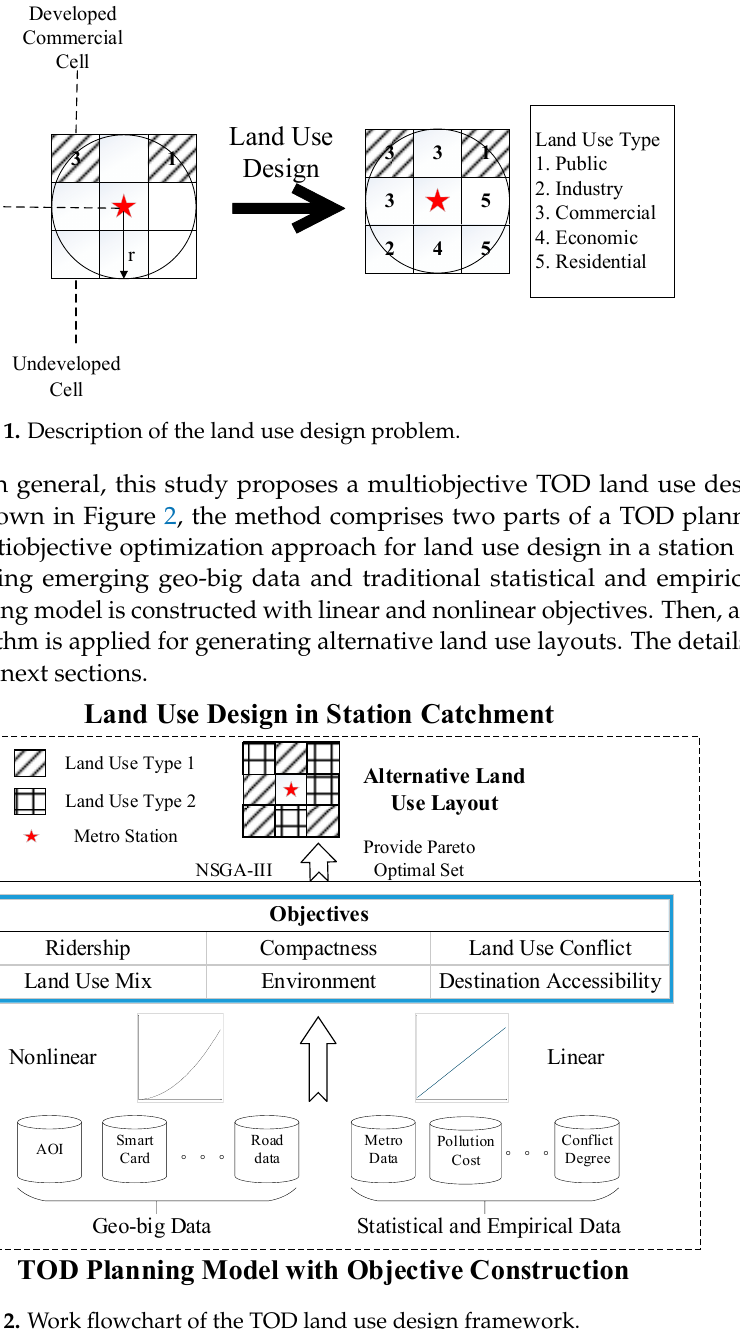
Figure 2. Work flowchart of the TOD land use design framework.